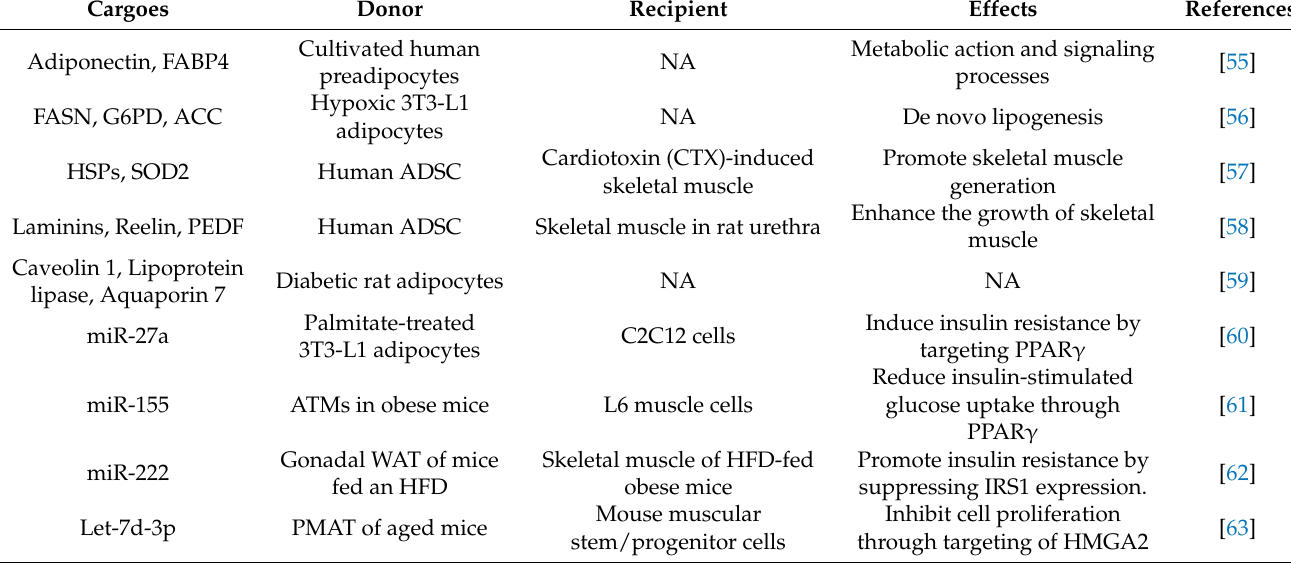
Table 1. Summary of adipose-derived exosomes cargoes and their effects in adipocyte–myocyte